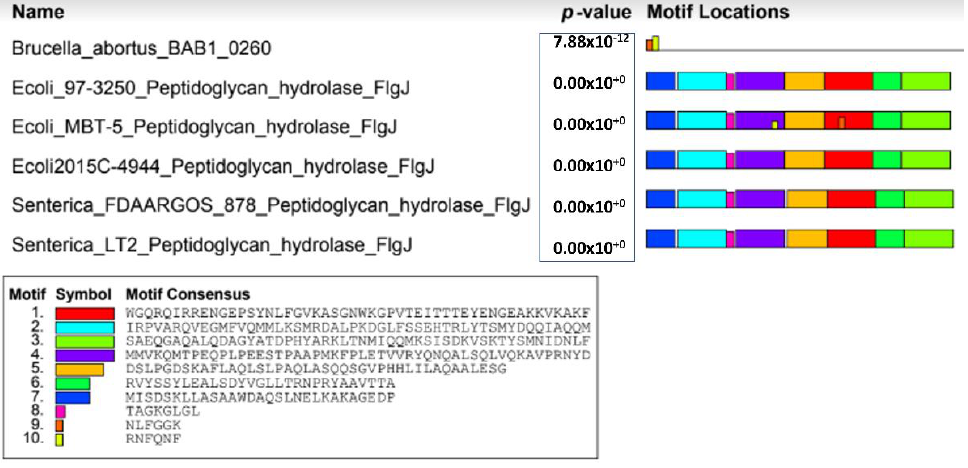
Figure 3. P -value of conserved motifs related to flgJ gene of Brucella abortus 2308. Bioinformatics tool used: http://meme-suite.org(accessed on 15 November 2021). used: http://meme-suite.org (accessed on 15 November